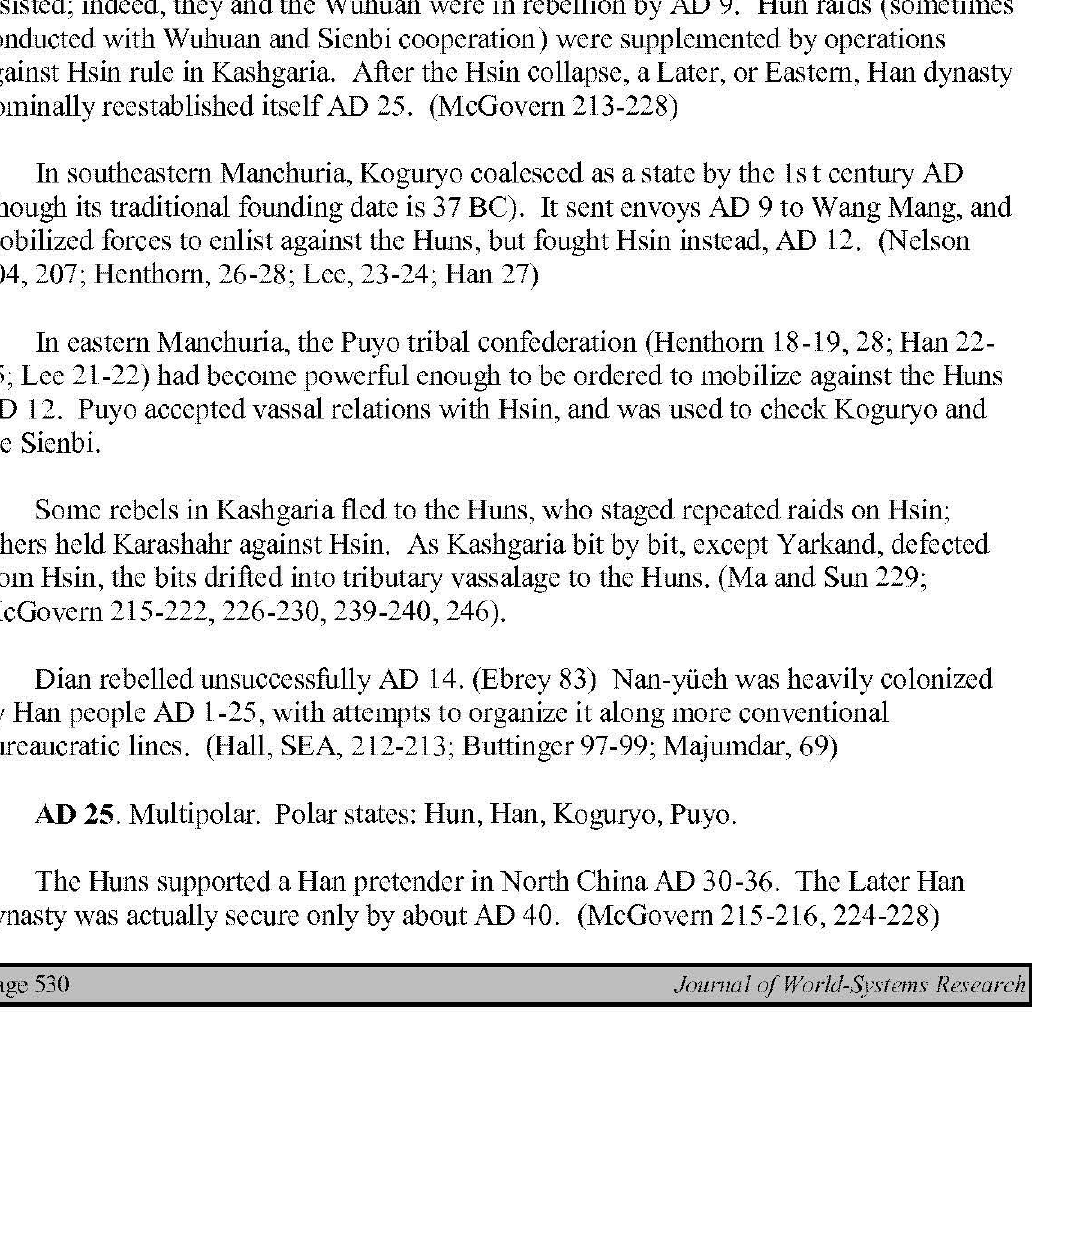
25 BC. Universal Empire. Metropole: